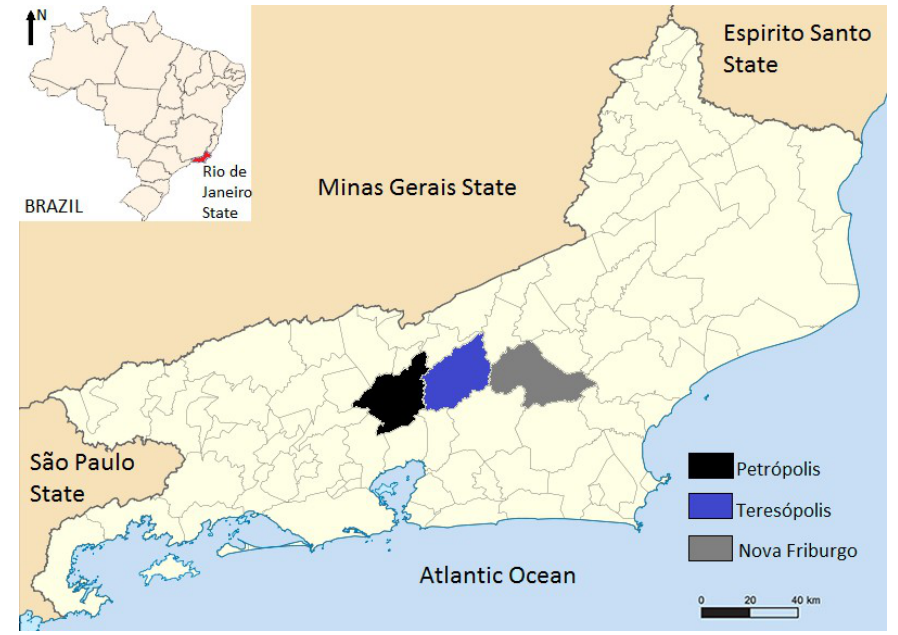
Figure 2. Study area location.